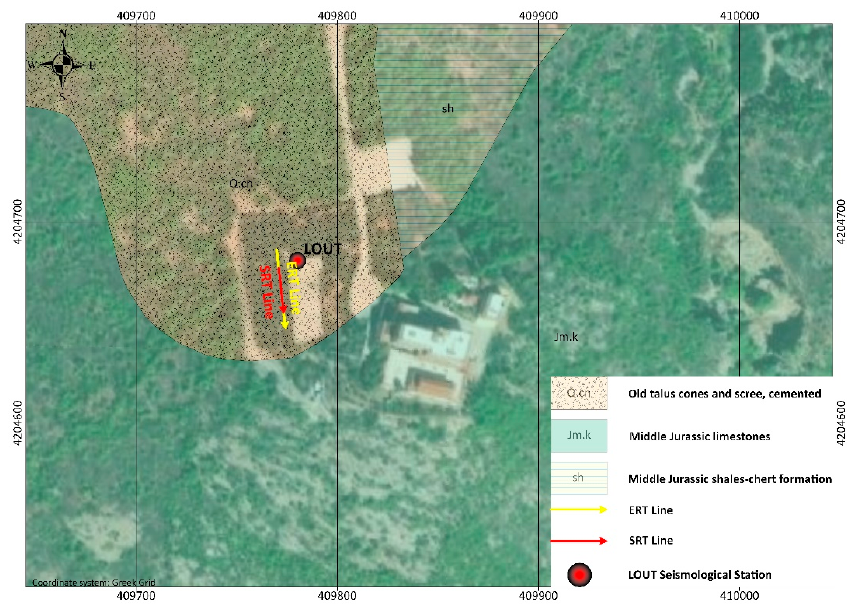
Figure 9. Location of the seismological station LOUT and the geophysical measurements along with the geology of the area.